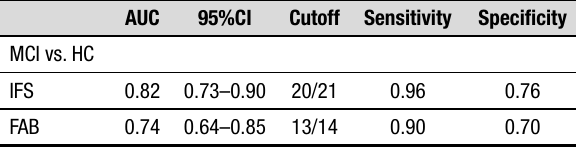
Table 4. Sensitivity, specificity, area under the curve, and cutoff of Frontal Assessment Battery and INECO Frontal Screening for mild cognitive impairment patients vs. healthy